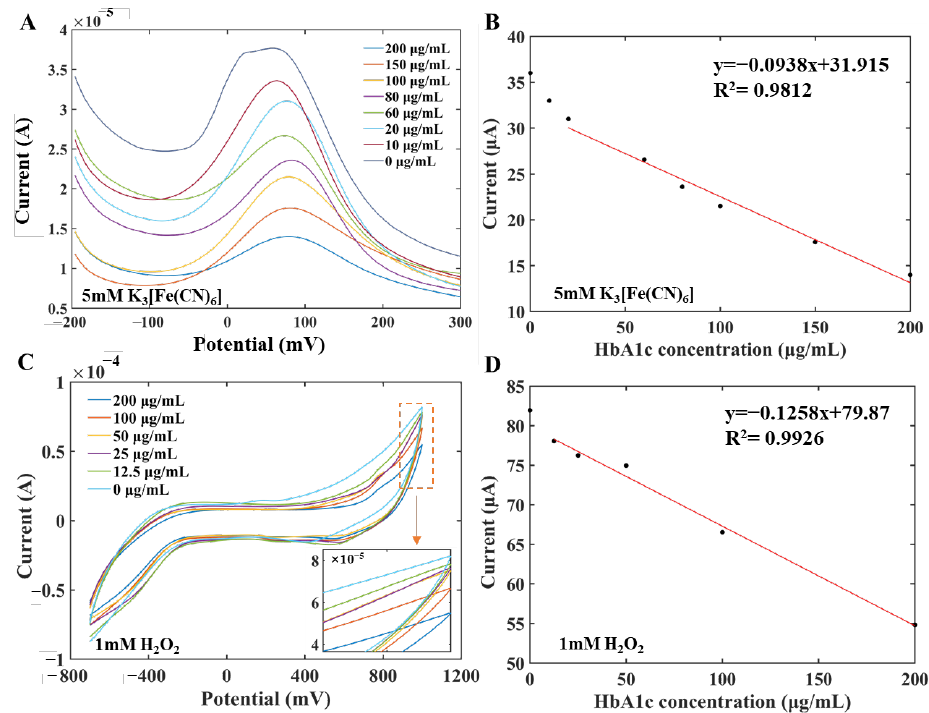
Figure 5. Measurement curves and linear fitting diagram of the modified working electrode for different concentrations of HbA1c. ( A ) DPV measurement curves of the modified working electrode for different concentrations of HbA1c. ( B ) Linear fitting diagram of DPV peak current curves. ( C ) CV measurement curves of the modified working electrode for different concentrations of HbA1c. ( D ) Linear fitting diagram of CV current curves.